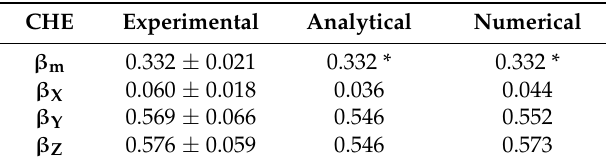
Table 1. Coefficients of hygroscopic expansion. Experimental scatter is reported with one standard deviation for the coefficient of hygroscopic expansion (CHE). * indicates an input parameter for the models. CHE